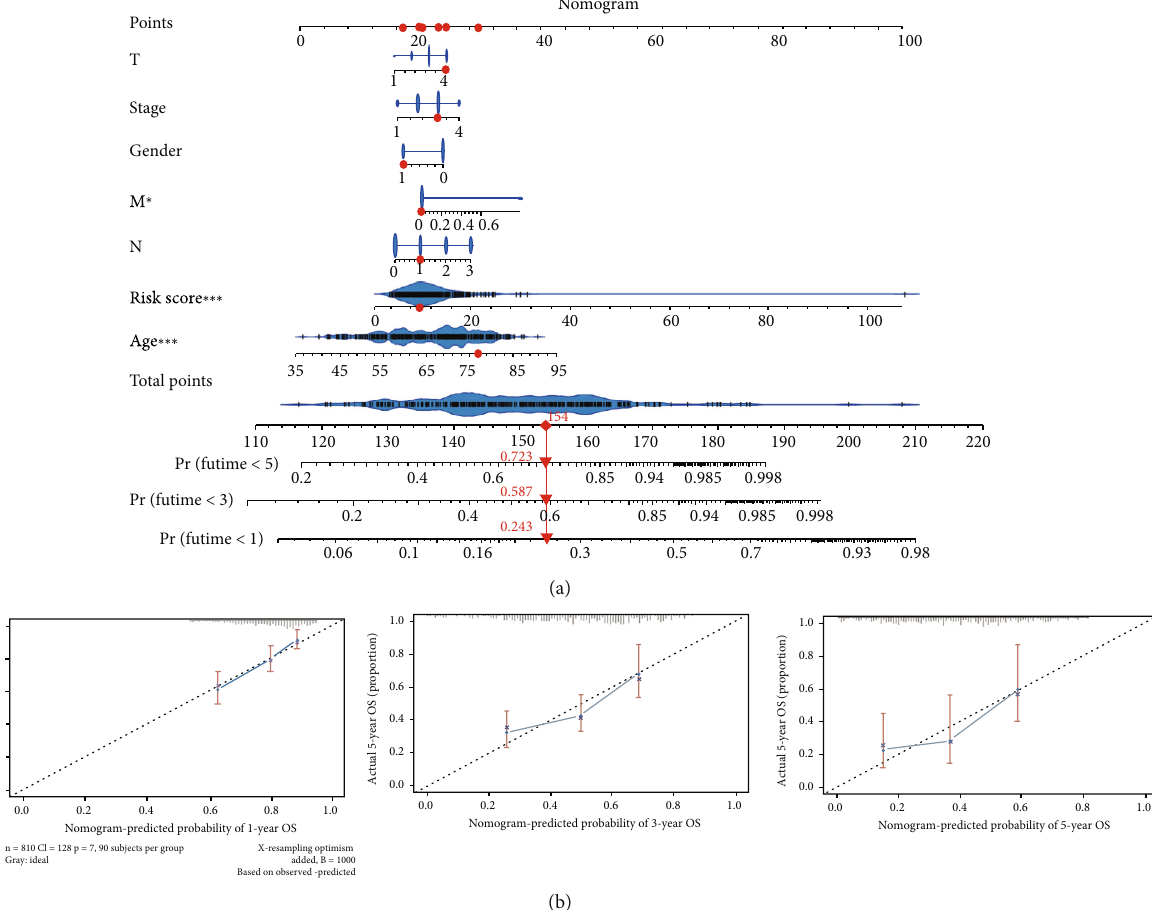
Figure 11: The construction of a Nomogram. (a) We constructed the Nomogram based on the risk value and clinical characteristics of the gastric cancer patient model, and predicted the 1, 3 and 5 year mortality of the patient TCGA-HU-A4Gy. (b) calibration curves of nomogram for prediction of prognosis at 1, 3 and 5 years in patients with gastric